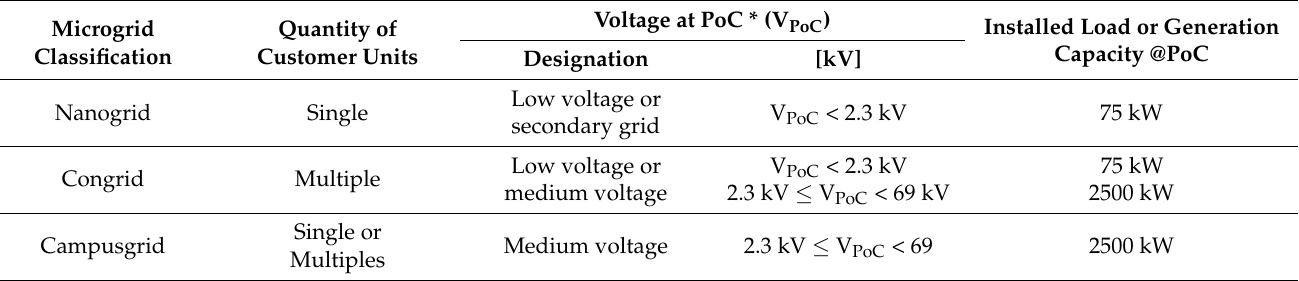
Table 3. Classification of microgrids—considering the technical and regulatory